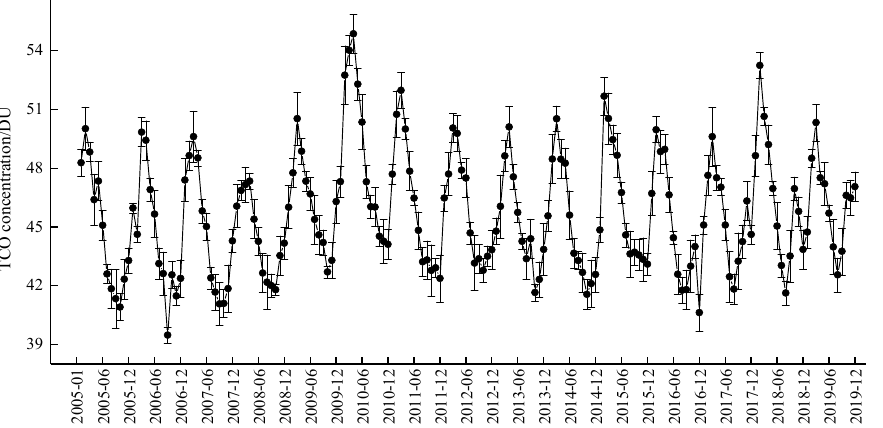
Figure 7. The trend of monthly TCO concentration in China (mean ± se).